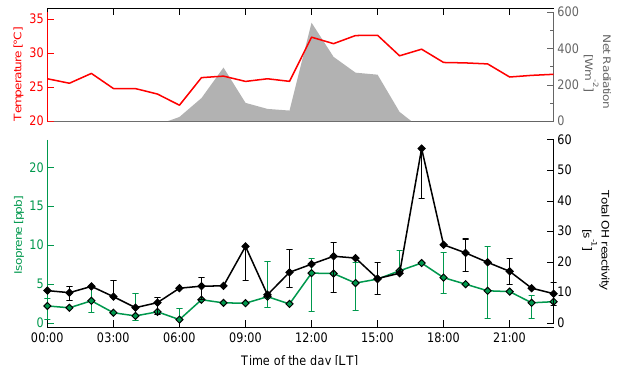
Figure 23. Isoprene and total OH reactivity measurements dur- ing November 2012 at the highest point above the canopy (79m), binned as 60min medians for all periods when both data were avail- able (about 4 days). The isoprene mixing ratio scale (left axis) was set to match its contribution to the total OH reactivity (1ppb iso- prene = 2.46s − 1 isoprene OH reactivity), which is presented on the right axis. The upper panel shows the diel variation of tempera- ture (measured at 81m) and the net